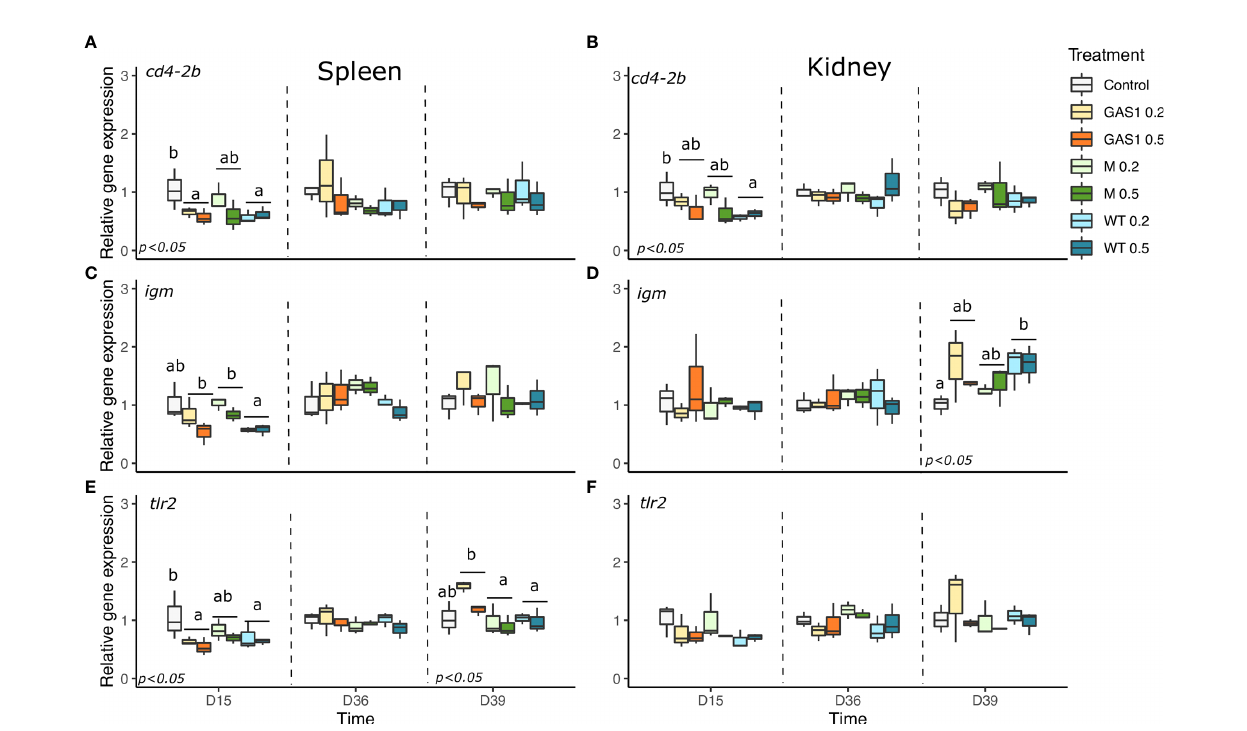
FIGURE 4 | Effects of dietary beta glucan on T-helper ( cd4-2 b ), humoral ( mIgM ) and membrane protein ( TLR 2 ) genes expressions in the spleen and kidney of fi sh sampled during the nutrient test on D15 and D36, or 2 days after the bacterial challenge (D39). (A – F) are expression levels of cd4-2 b , mIgM , TLR 2 in spleen and kidney, respectively. Relative transcript (mRNA) levels were determined by real-time RT-PCR and normalized by the arithmetic mean of ef-1 a expression. Values are expressed as mean ± SD of 3 pool samples per experimental condition (3 fi sh per pool sample). Statistical differences, highlighted by letters, are indicated for glucan concentrations in front of 0, 0.2, and 0.5% next to the corresponding plot, for glucan type by letter above the horizontal bar grouping the two doses of the same glucan, for glucan type × concentrations interactions above each box. P values are shown at the bottom of each graph at a given time point (D15, D36, or